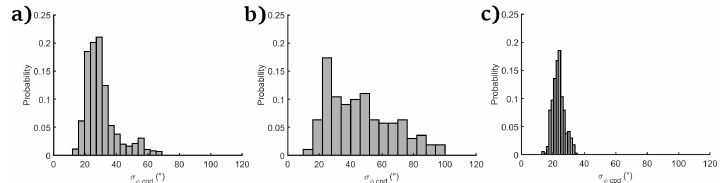
Figure 8. Normalized histograms of the std CPD associated to: ( a ) double sign signatures; ( b ) single-negative sign signatures; and ( c ) single-positive sign